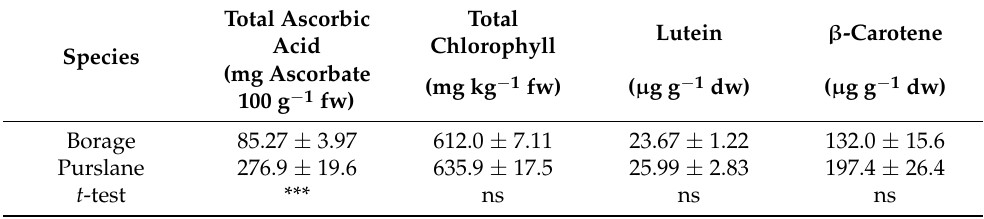
Table 4. Total ascorbic acid, total chlorophylls, and carotenoids (lutein and β -carotene) in microgreen extracts. Means were statistically separated using a two-tailed Student’s t -test. ns: Not significant; ***: p <